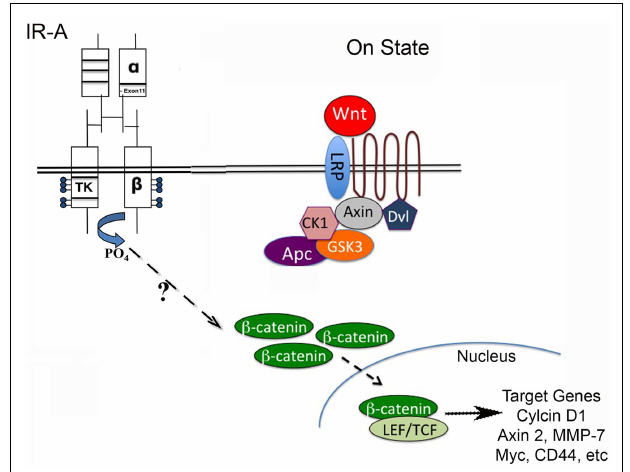
FIGURE 1 | Wnt/ β -catenin pathway regulates stem cell pluripotency and cell fate decisions during development . The Wnt pathway is activated when Wnt ligand binds to a Frizzled receptor, which then is brought into complex with the co-receptor LRP5/6. The activation of the Wnt pathway leads to stabilization of β -catenin through inactivation of the destruction complex (containing Axin, CK1, Gsk3 β , and Apc). β -catenin can then translocate to the nucleus and interact with LEF/TCF to regulate Wnt target genes. The stimulation of the insulin receptor isoform A (IR-A) in IGF-1R null (R-/IR-A) fibroblasts by insulin was shown to increase levels of β -catenin through a mechanism that is currently